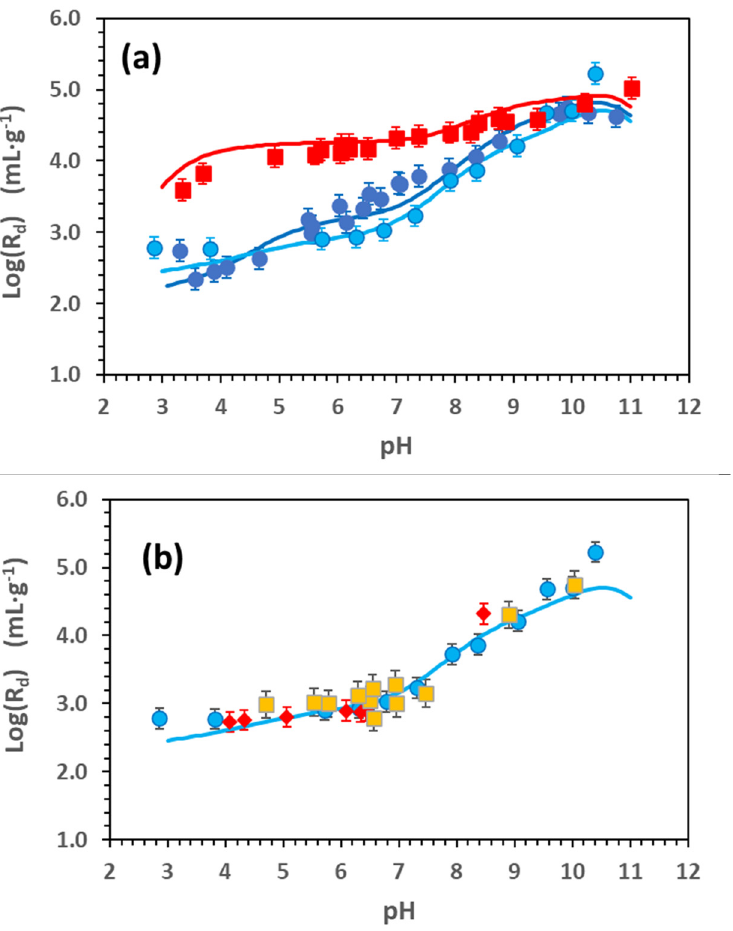
Figure 3. Cd adsorption edges in Na-smectite [0.57 − 0.86 g·L − 1 ]. ( a ) ( ) Comparison of sorption edges at two different Cd concentrations. [Cd] = 9.18 × 10 − 8 M and 0.1 M NaClO 4 ; ( • ) [Cd] = 1 × 10 − 5 M and 0.1M NaClO 4 ; ( ) [Cd] = 9.18·× 10 − 8 M and 0.01M NaClO 4 . ( b ) Comparison of sorption edges with different contents of chloride. ( • ) Reference standard test (Cd] = 1 × 10 − 5 M with HCl and CdCl 2 ); ( ) [Cd] =1·10 − 5 M with Cd(ClO 4 ) 2 and traces of 109 CdCl 2 (1·× 10 − 8 M); ( ) [Cd] =1·10 − 5 M without Cl (only HClO 4 and Cd(ClO 4 ) 2 . The line represents the model calculation with the parameters of